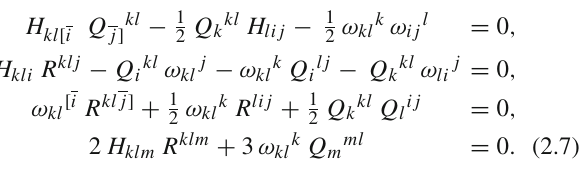
Table4 Bianchiidentitiesofthesecondformulationandtheircounting Class Bianchi Iden- tities of the Second for- mulation